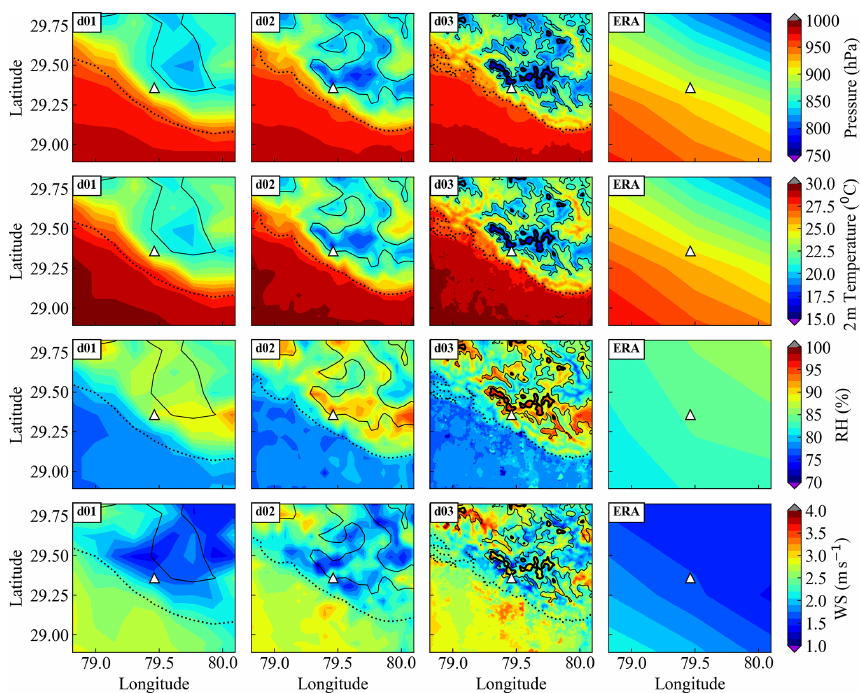
Figure 2. Contours in the first three columns show WRF results for the three domains (first column: d01, second column: d02, third column: d03), and the fourth column shows corresponding parameters from the ERA-Interim reanalysis. The first row shows mean surface pressure during the monsoon (JJAS), the second row shows 2m temperature (in ◦ C), the third row shows 2m relative humidity (RH; %), and the bottom row shows 10m wind speed (WS; ms − 1 ) along with three elevation contours at 500m (dashed), 1500m (thin solid), and 2000m (thick